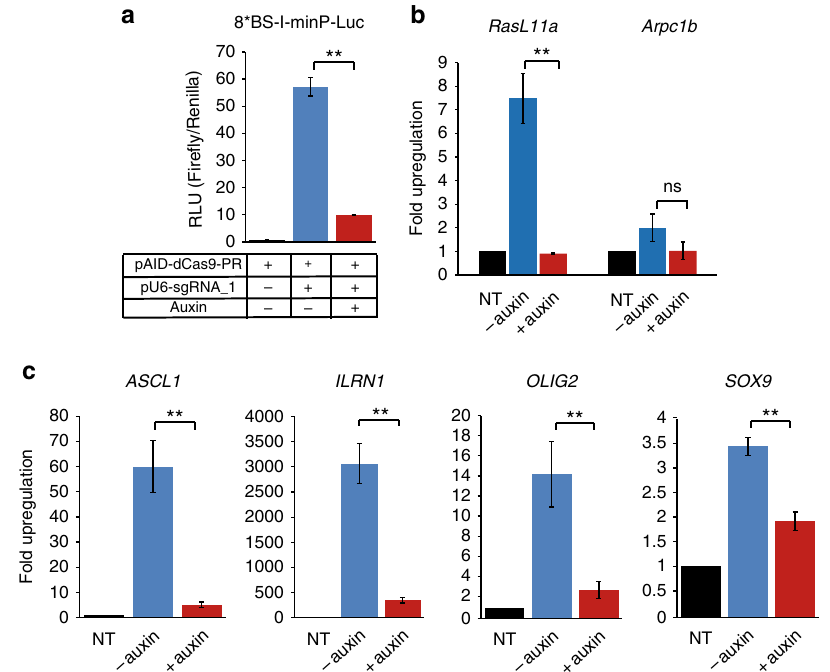
Fig. 2 Auxin controllable functional activity of the AID-dCas9-PR synthetic transcription factor a Dual-luciferase assay on HEK293s transiently transfected with AID-dCas9-PR, an sgRNA expression construct (gRNA_1), a construct containing fi re fl y luciferase under control of a minimal promoter with 8 binding sites that are recognised by gRNA_1 (p8*BS-I-minP-Luc) and a Renilla luciferase control plasmid. Auxin was added to the cultures where indicated. b A stably transfected CHO cell line with AID-dCas9-PR was transfected with guide RNAs targeting the promoter regions of RasL11a and Arpc1b. RNA levels after 48 h were assessed by rtqPCR. Upregulation was largely abrogated in the presence of auxin. c Upregulation of endogenous genes in HEK293 cells by auxin-inducible degron-tagged dCas9-PR is similarly affected by the presence of auxin. Expression levels of four genes, ASCL1, IL1RN, OLIG2 AND SOX9 , representing a wide range of potential upregulation were assayed by rt-qPCR. Error bars denote ± s.d. ( n = 3), (2-tailed t -test, (**) P < 0.01, (*) P < 0.05, (ns) not signi fi cant). Black columns, no sgRNA transfected (NT); Blue columns, no auxin added; Red columns, auxin